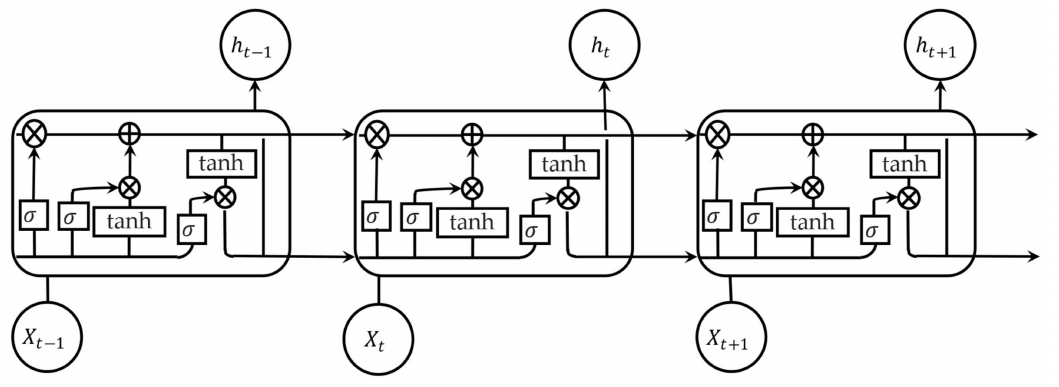
Figure 3. A block inside an LSTM network. Adapted from